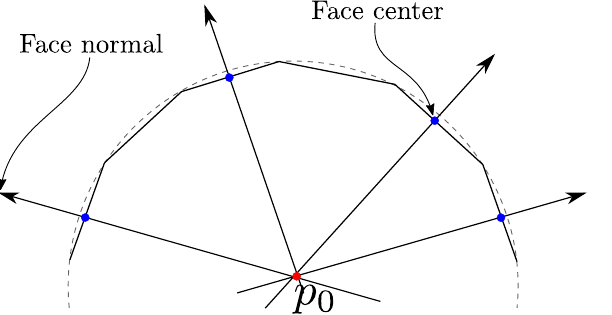
Figure 7. p 0 calculation with the intersection of lines [ b i , n i ] whose directions are triangle normal vectors n i and pass through triangle baricenters b i .